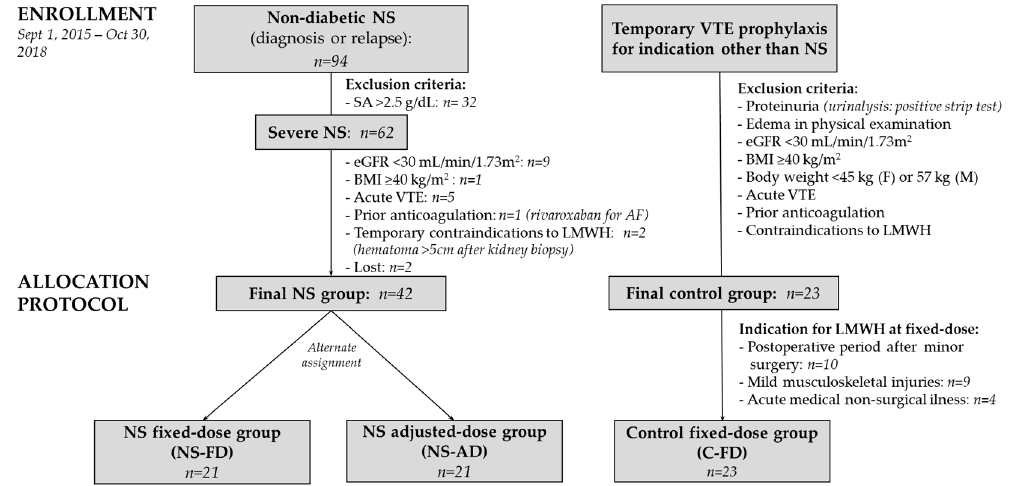
Figure 1. Flowchart of the study protocol. NS, nephrotic syndrome; SA, serum albumin concentration; eGFR, estimated glomerular filtration rate; BMI, body mass index; VTE, venous thromboembolism; AF, atrial fibrillation; LMWH, low- molecular-weight heparin; F, female; M, male; IBW, ideal body